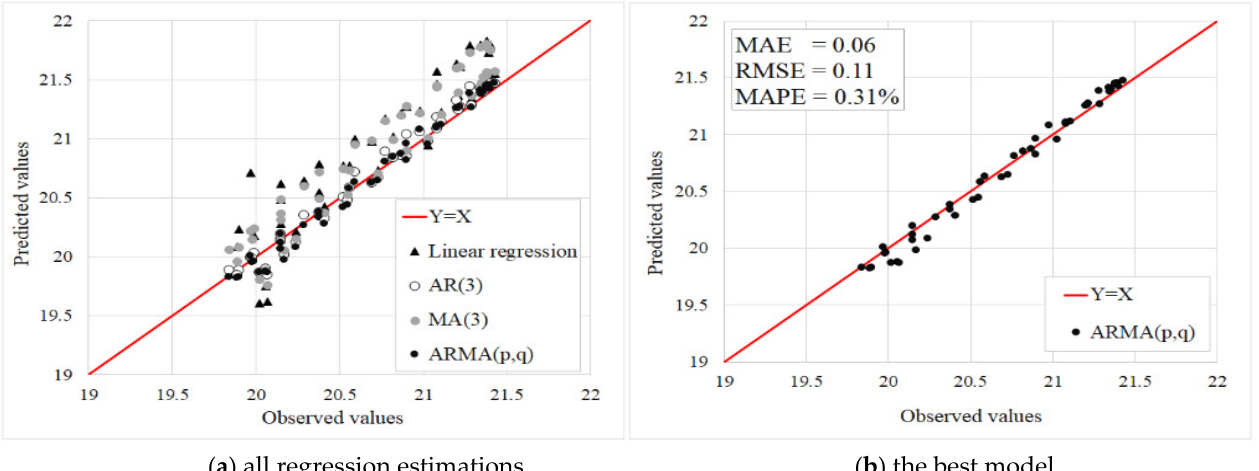
Figure 3. The case of missing value estimation in the time series of soil temperature (°C), 48 h data gap length, 16–18 August 2016. Calculated by the authors based on hourly time series, the data of monitoring network in Poluyamki, Altai Krai, Russia.